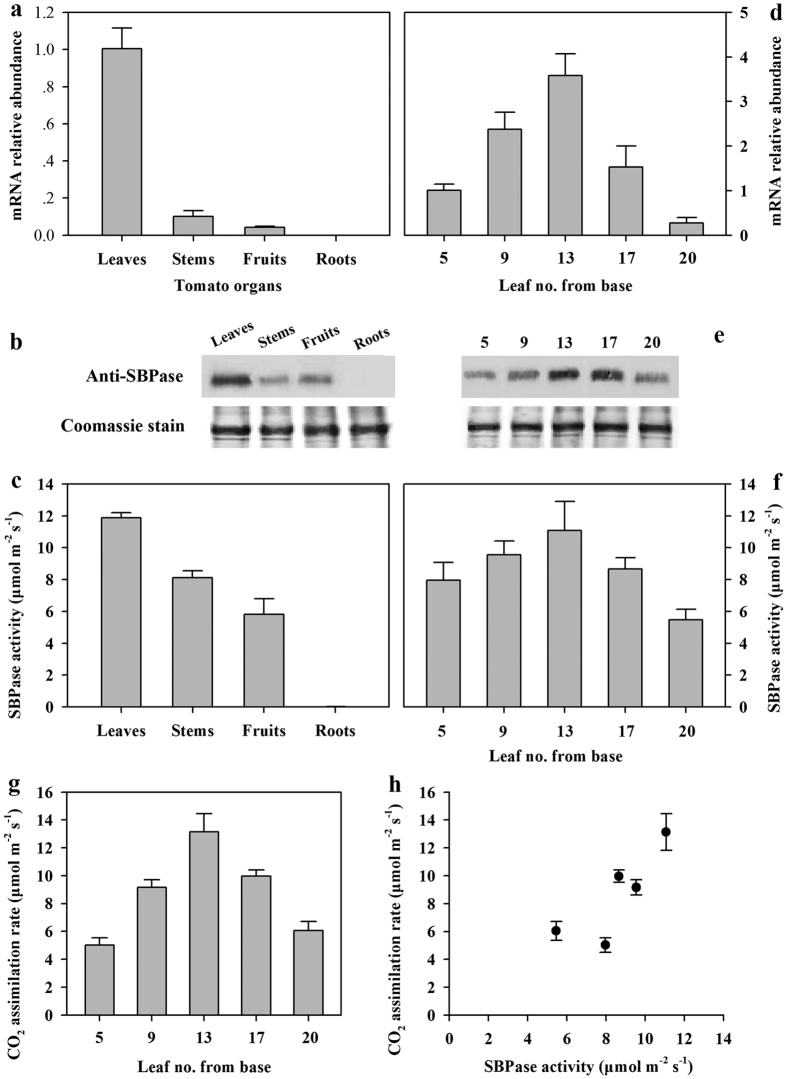
SlSBPase mRNA abundance, SBPase activity and protein levels in different tissues and during leaf development in tomato plants.All measurements were done on 20-leaf tomato plants. (a,d) SlSBPase mRNA abundance was measured by quantitative real-time PCR using total RNA separately isolated from different organs (fully expanded leaves, one-week old fruits, stems, roots) and leaves at different developmental stages including post-maturation leaves (leaf no. 5 from base), mature fully expanded leaves (leaf no. 9, 13), new fully expanded leaves (leaf no. 17) and young expanding leaves (leaf no. 20) and in tomato plants. (b,e) Protein levels. 25 μg protein samples from different tissues were separated by SDS-PAGE. SBPase protein was stained by coomassie blue and was subjected to western blot analysis with an anti-SBPase polyclonal antibody. (c,f) SBPase activity. The same tissues for SlSBPase mRNA analysis were sampled for SBPase activity assay. (g) CO2 assimilation rate in leaves at the different developmental stages. (h) CO2 assimilation rate as a function of SBPase activity. The results are the means ± SDs (n = 4).